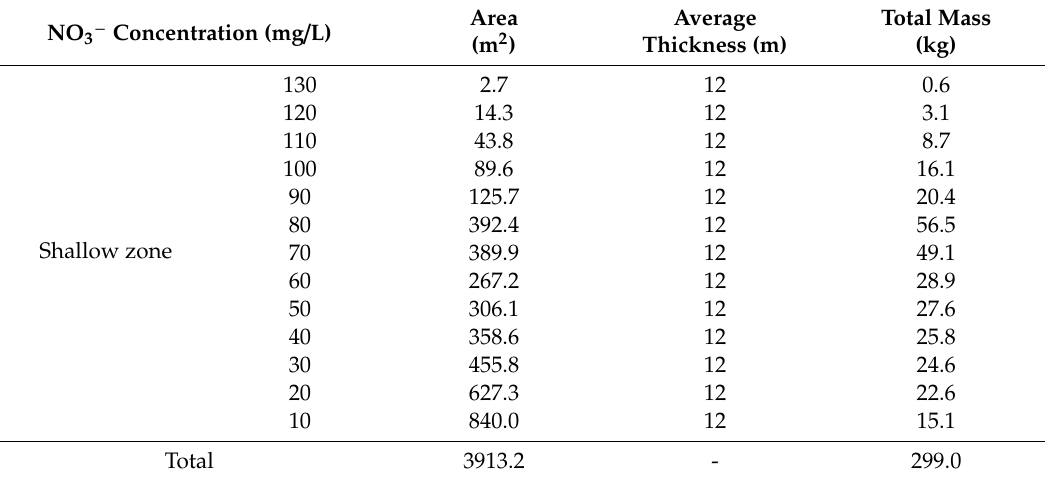
Table 4. Nitrate mass values (kg) in shallow and intermediate